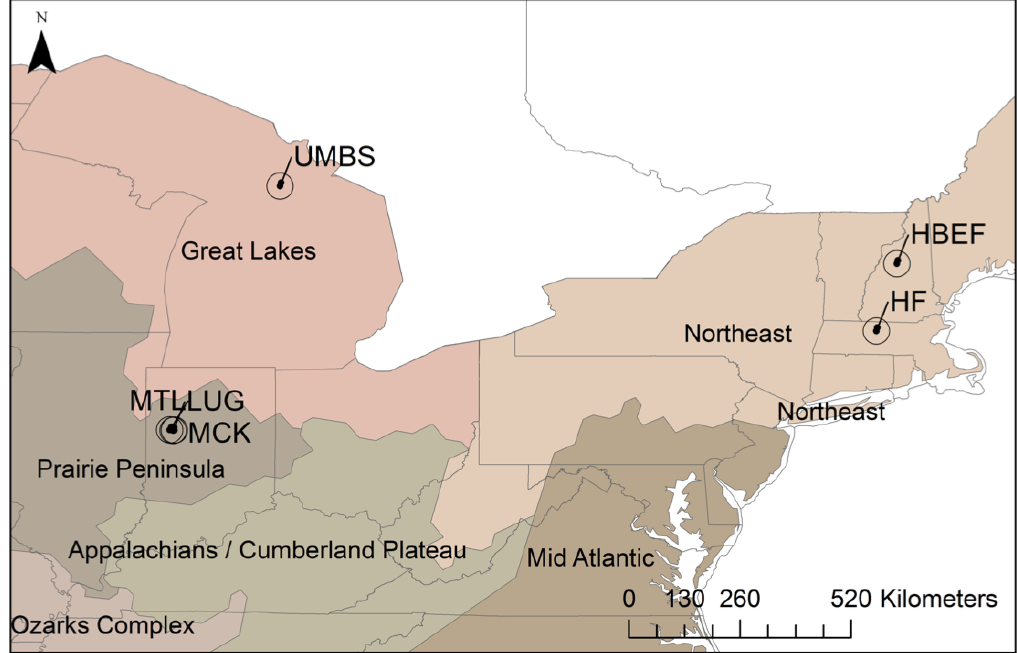
Figure 2. Sampling locations of the six forested landscapes for which portable canopy LiDAR data was collected in eastern USA. Martell Forest (MTL), McCormick Woods (MCK), and Lugar Farm (LUG) are located in the Prairie Peninsula ecoregion, Hubbard Brook (HBEF) and Harvard Forest Hemlock plot (HF) are in the Northeast ecoregion, and (UMBS) is in the Great Lakes forest ecoregion.